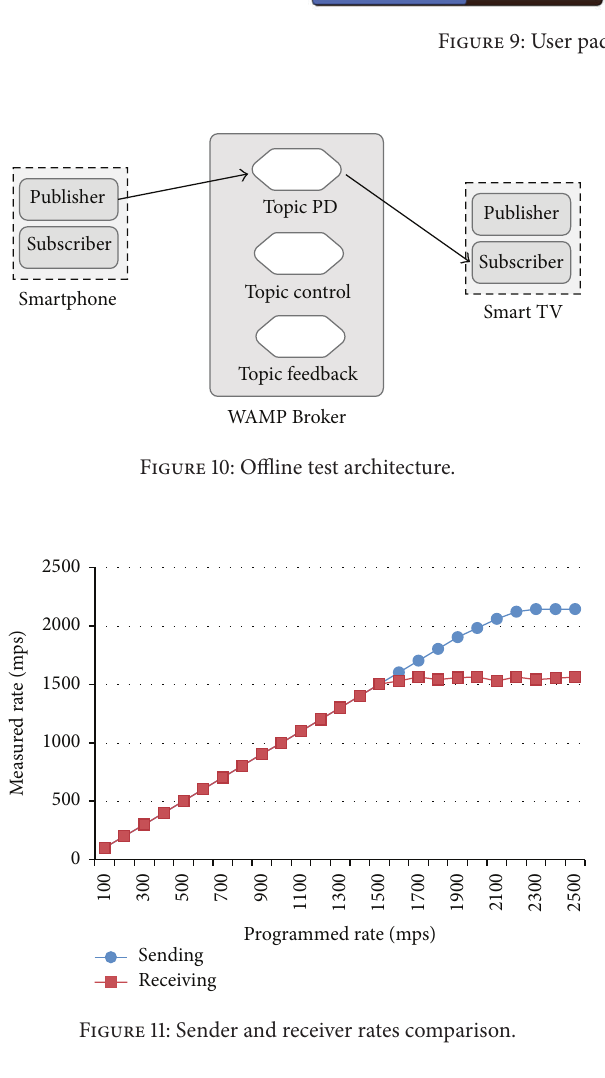
to the graph, the MST for the middleware is 1500 mps (with hardware support features described on Table 4).